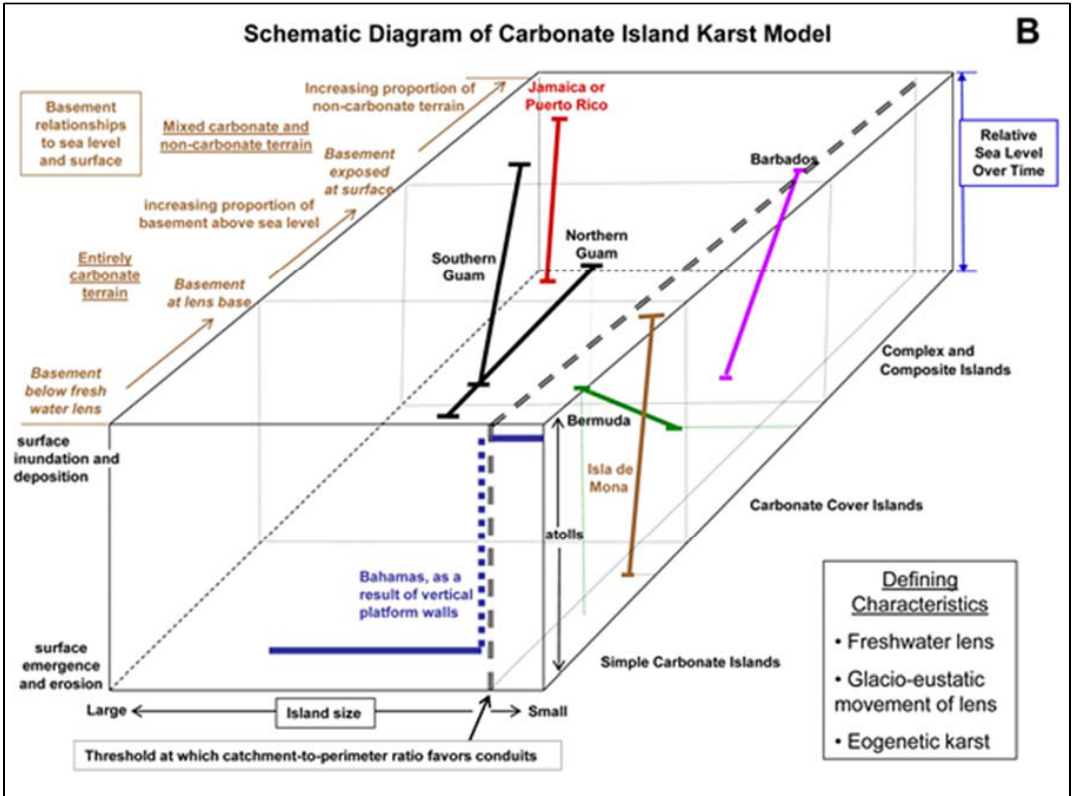
Figure 2. Three-dimensional expression of the CIKM model, modified from Jenson et al. [17]. ( A ) Schematic CIKM box with three axes: the long horizontal axis is the island category, based on the CIKM, with composite and complex categories combined; the short horizontal axis is the island size; and the vertical axis is the sea-level position. The island size transition to conduit flow is placed to the right based on the 10–40-km placement of island size for the diffuse to conduit transition presented in this paper. ( B ) Schematic CIKM box with island examples showing how island character changes as sea-level fluctuates; for example, becoming a new type of island within the CIKM classification scheme, or how their size changes with sea-level. See the text for a discussion.